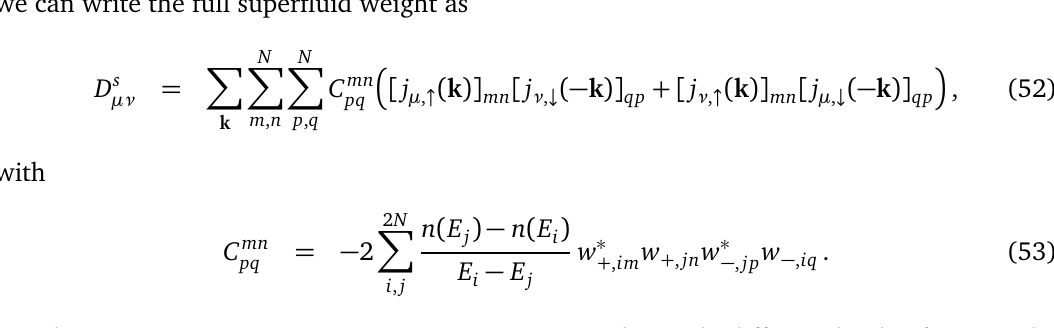
, and staggered i